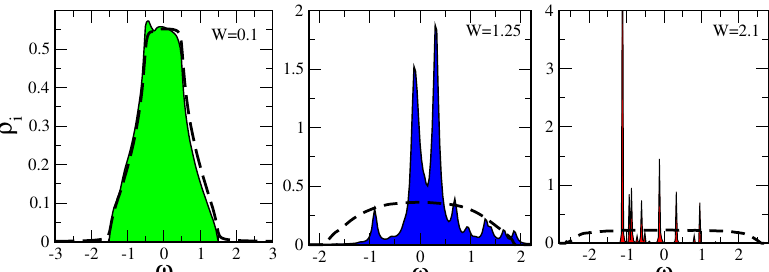
Figure 5. The global average (dashed lines) and the local (solid lines) DOS of the 3D Anderson model for small, moderate, and large disorder strength W with units 4 t = 1 where t is the near-neighbor hopping (see text for details).